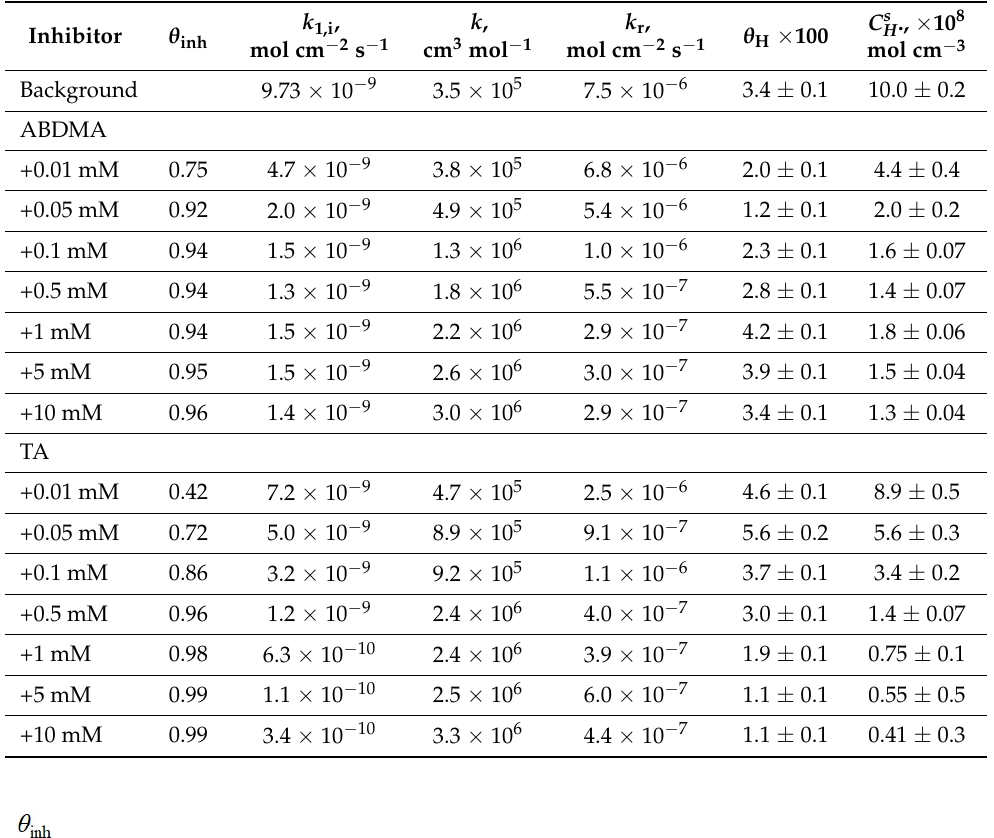
Table 1. Kinetic constants, coverage of the metal surface with the inhibitors ( θ inh ) and hydrogen atoms ( θ H ), and surface concentration of diffusion-mobile hydrogen ( C s (E = − 0.3 V) of steel in 2 M HCl solution containing ABDMA and TA.